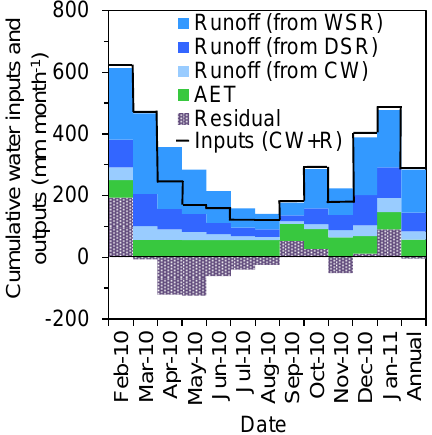
Figure 9. Cumulative water inputs (rainfall and cloud water inter- ception) are represented by the black line. Cumulative water outputs (river run-off and actual evapotranspiration) and the residual are separated out into cumulative coloured stacked bars. Run-off is sep- arated into its three sources: wet-season rainfall (WSR), dry-season rainfall (DSR), and cloud water (CW) (Table 3). The study period is separated by month, and the monthly balance is determined for the study year, February 2010 to January